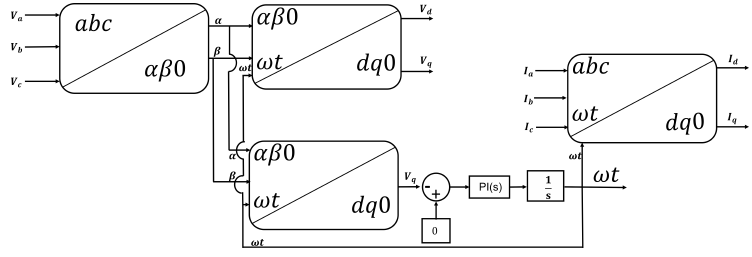
Figure 4. Illustration of transformation and PLL [21], © 2021